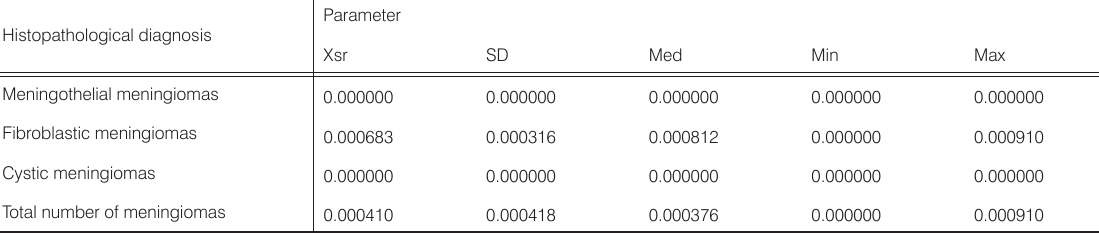
Table 4. The value of ADC (mm 2 /s) in peritumoral brain tissue in comparison with histopathological diagnosis.